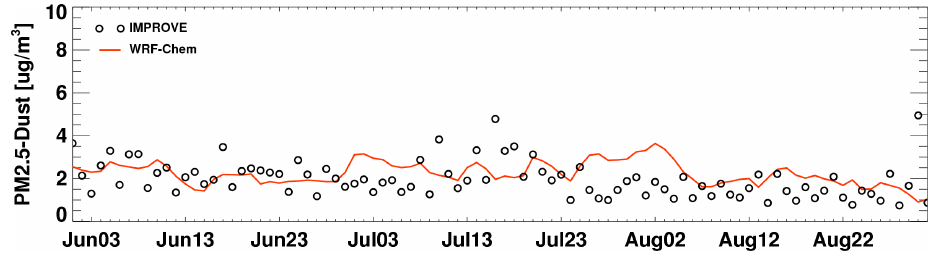
Fig. 3. Daily fine dust (with diameter < 2.5µm) mass concentrations averaged for the seven IMPROVE sites (Fig. 2) over the southwestern Figure 3 Daily fine dust (with diameter < 2.5 µ m) mass concentrations averaged for the 5 US from the IMPROVE measurements and WRF-Chem simulations for June–August seven IMPROVE sites (Figure 2) over the southwestern US from the IMPROVE 6 measurements and WRF-Chem simulations for June-August, 1995-2009. 7